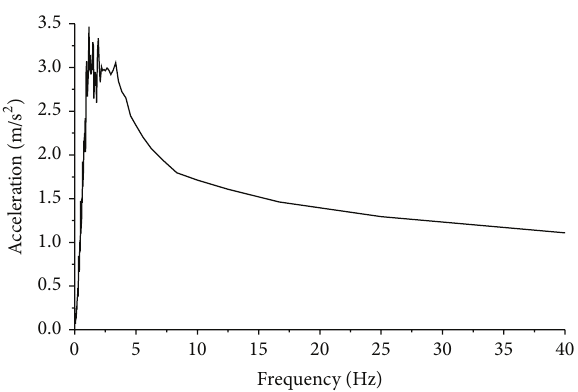
Figure 2: Fourier amplitude of 𝑎 1 .